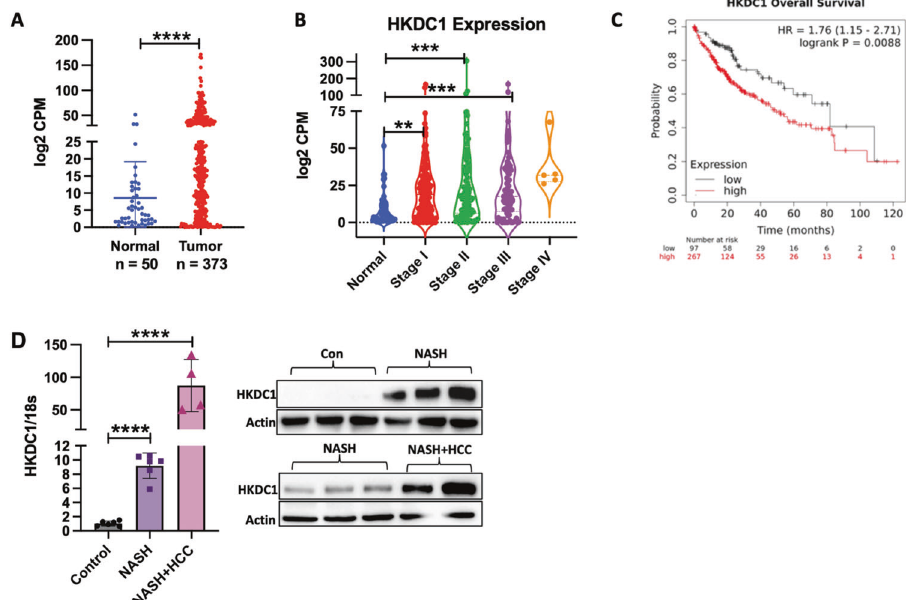
Fig. 1 HKDC1 is upregulated in LC. mRNA expression data of HKDC1 in liver cancer (LIHC) in human patients mined from the TCGA dataset is shown for A normal and LC patient samples where T denotes tumor ( n = 369) and N = denotes normal surrounding tissue ( n = 50) and B